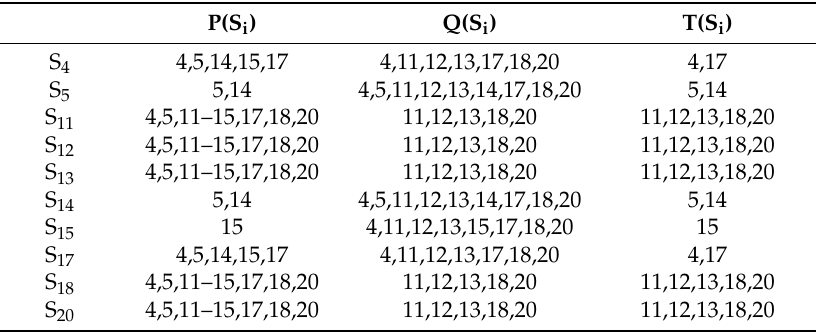
Table 10. Fifth level of reachability set, leading set, and their intersection.